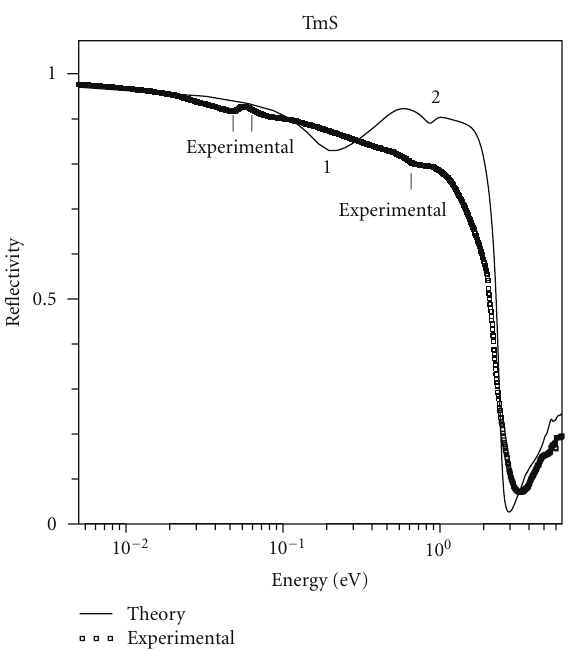
Figure 65: Calculated optical reflectivity spectrum of TmS [384] compared with experimental data